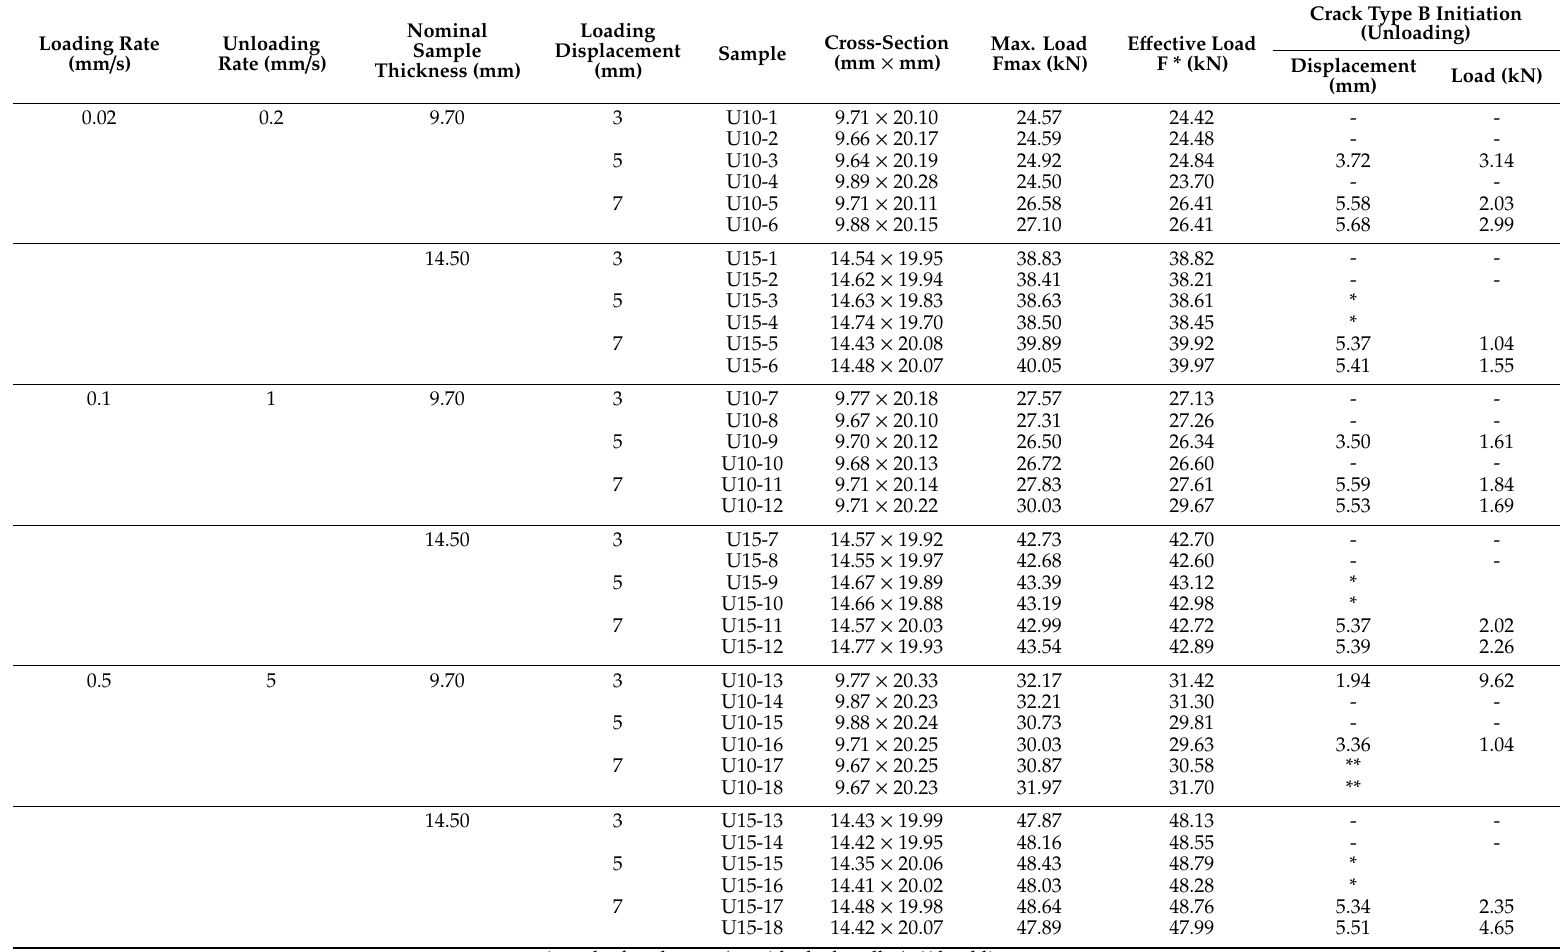
Table A4. Fracture load and displacement for the samples with